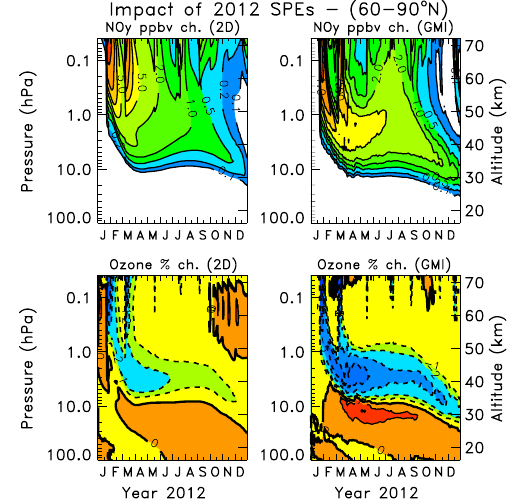
Fig. 11. ( Left ) Difference between GSFC 2-D model simulation “B (with SPEs)” and “A (without SPEs)”. ( Right ) Difference be- tween GMI 3-D CTM simulation “D (with SPEs)” and “C (without SPEs)”. NO y ( Top ) and Ozone ( Bottom ) for 60–90 ◦ N are given for all months of 2012. The contour intervals for the NO y differences are 0.1, 0.2, 0.5, 1, 2, 5, 10, 20, and 50ppbv. The contour intervals for the Ozone differences are − 20, − 10, − 5, − 2, − 1, 0, 1, and